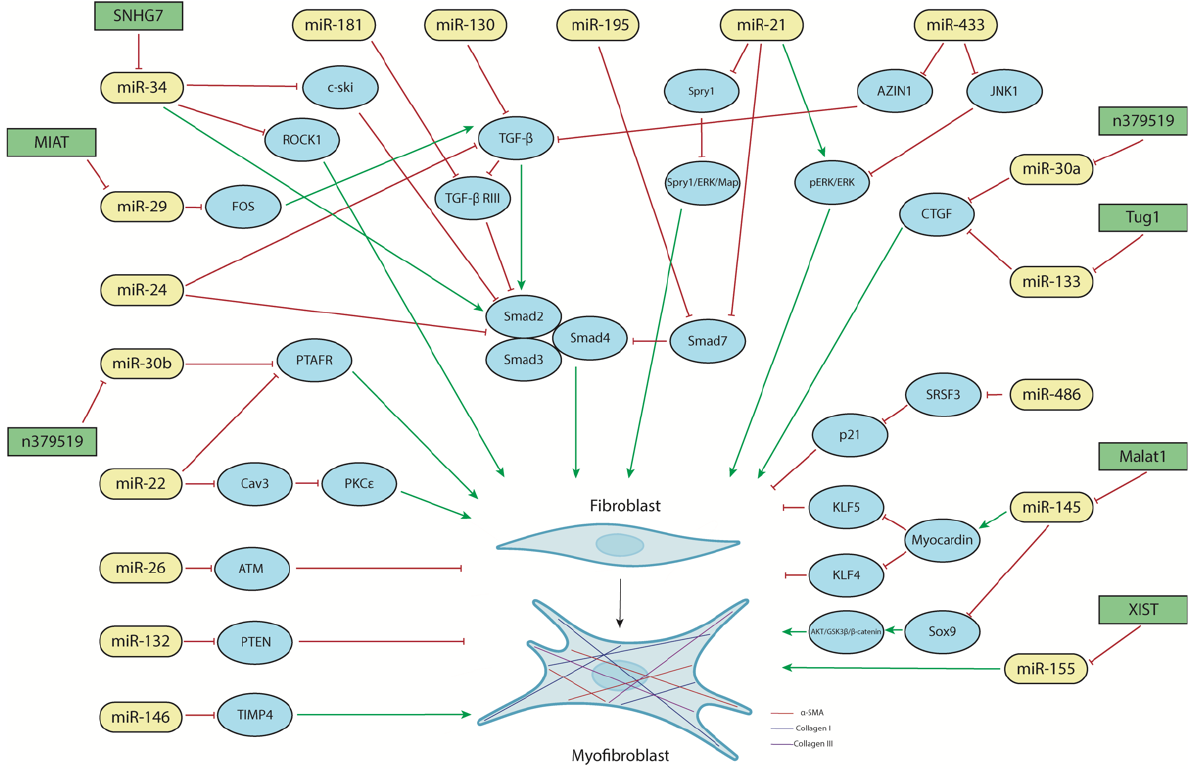
Figure 2. Cardiac fibrosis. Schematic representation of the main miRNAs’ and lncRNAs’ gene-regulatory networks reported to be involved in distinct signaling pathways leading to cardiac fibrosis. Green arrows delineate the ncRNAs that activate the signaling pathways while those depicted in red inhibit such signaling pathways. Note that ncRNAs can influence multiple and distinct signaling pathways leading to the activation of fibroblasts in myofibroblasts and thus ECM deposition. circRNAs are depicted in green, microRNAs are depicted in yellow, and the different signaling pathways modulating the inflammatory response are depicted in blue.